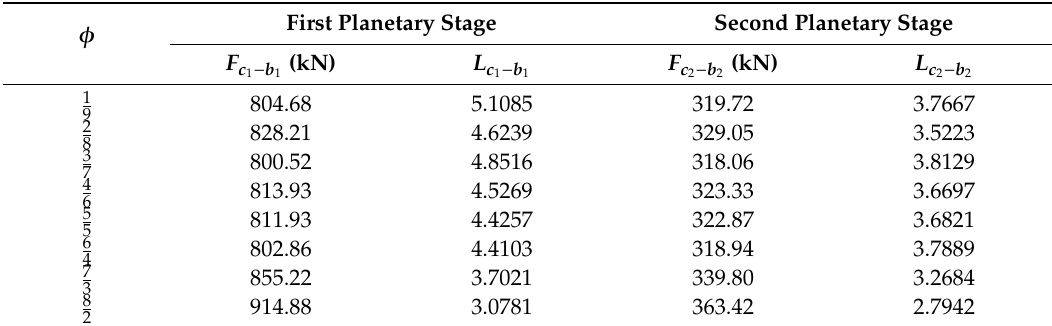
Table 9. Force and life of planet gear bearing of